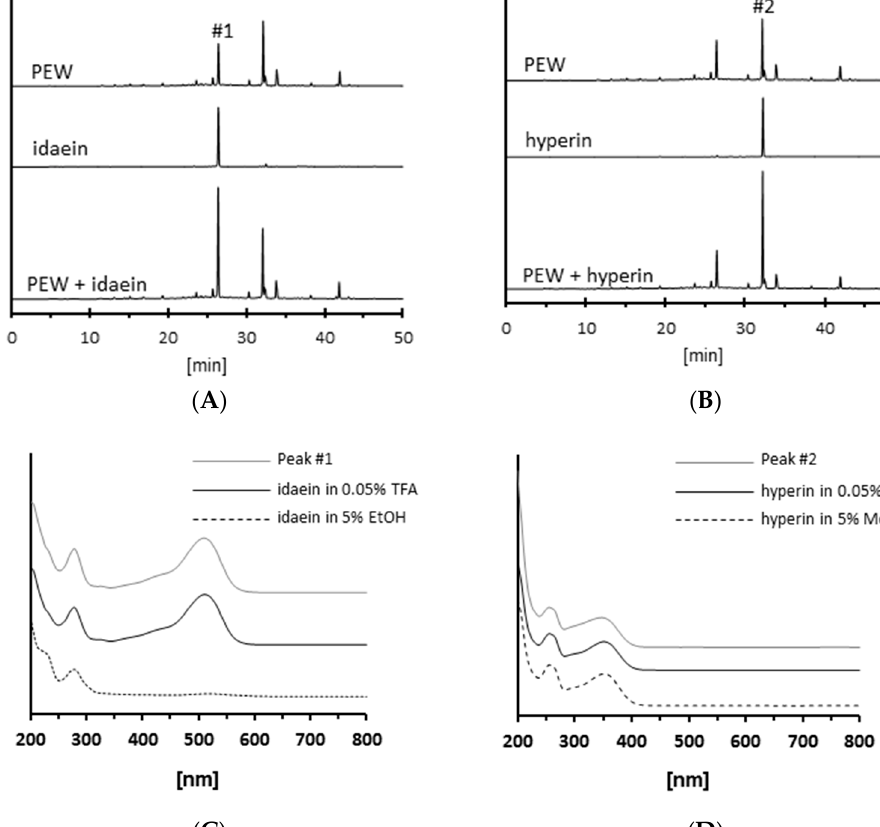
Figure 5. Comparison of the isolated peaks from Persicaria hydropiper extract with idaein and hyperin. ( A , B ) Ten micrograms of PEW was mixed with either authentic standard of idaein or hyperin (0.4 nmol) and analyzed using HPLC-UV at 270 nm. ( C , D ) UV-vis absorption spectrum of the isolated peaks and authentic standards of idaein and